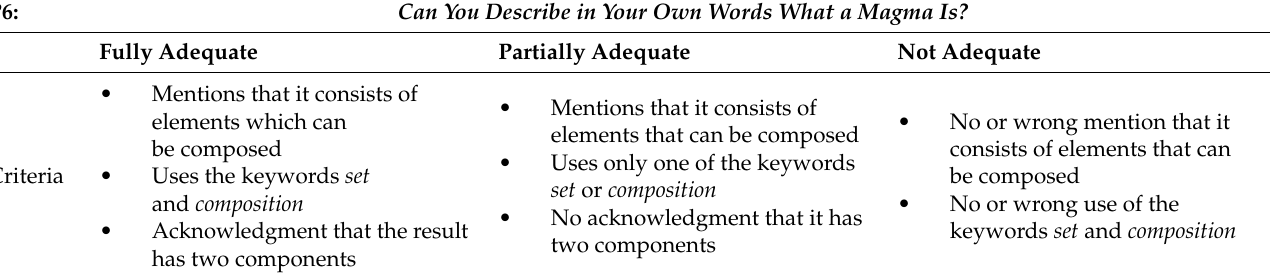
Table A14. Coding manual for the paraphrasing of key idea